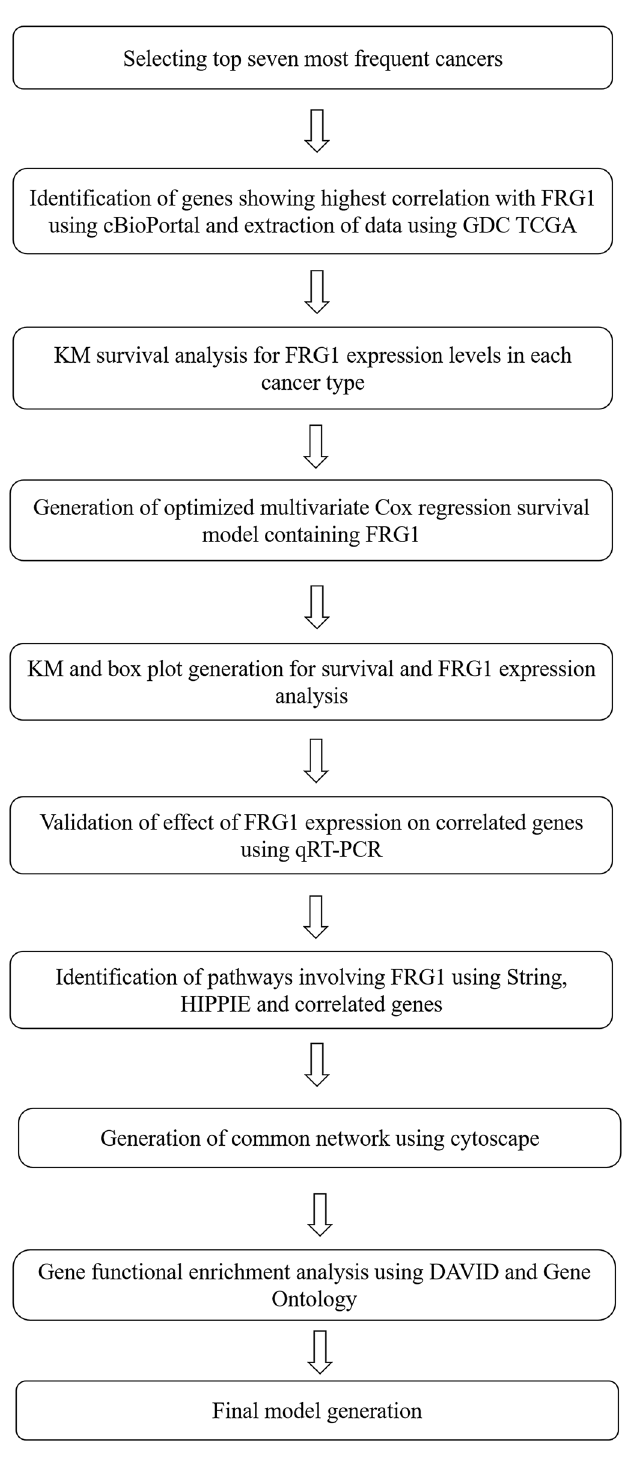
Figure 1. Flow chart of the study